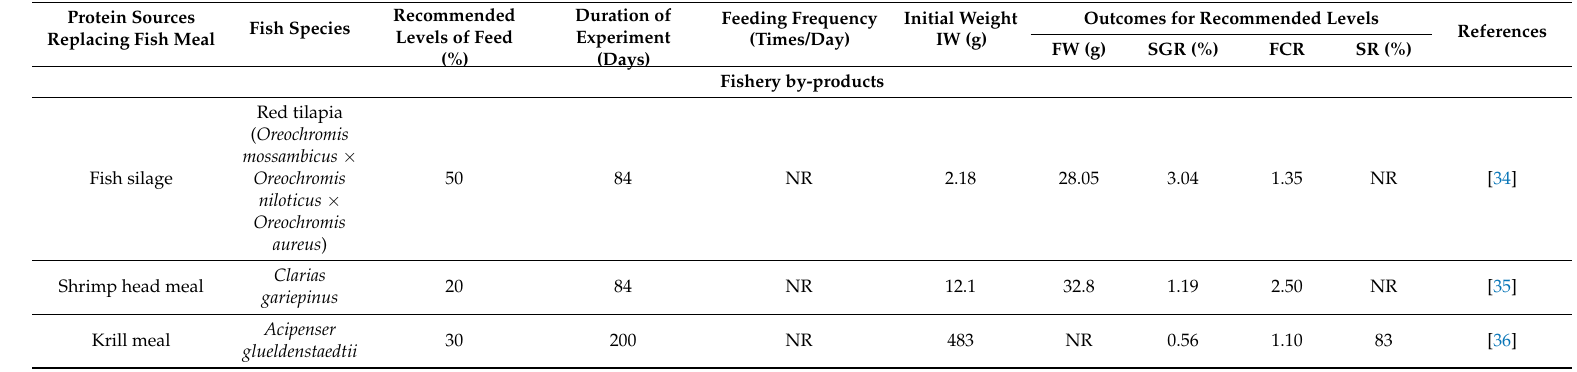
Table 2. Summary of studies that assessed animal protein sources as a fishmeal replacement in fish diets in aquaculture. Final weight (FW in grams), specific growth rate (SGR in percentage (%)), feed conversion ratio (FCR), and survival rate (SR in %) were used as the assessment parameters to measure